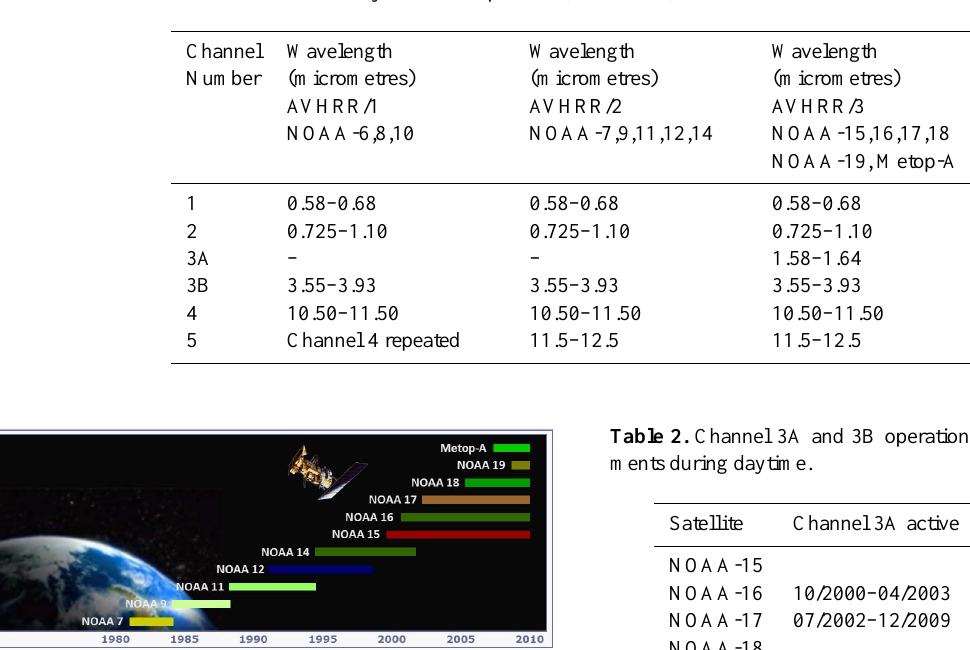
Table 1. Spectral channels of the Advanced Very High Resolution Radiometer (AVHRR). The three different versions of the instrument are described as well as the corresponding satellites. Notice that channel 3A was only used continuously on NOAA-17 and Metop-1. For the other satellites with AVHRR/3 it was used only for shorter periods (see Table 2).